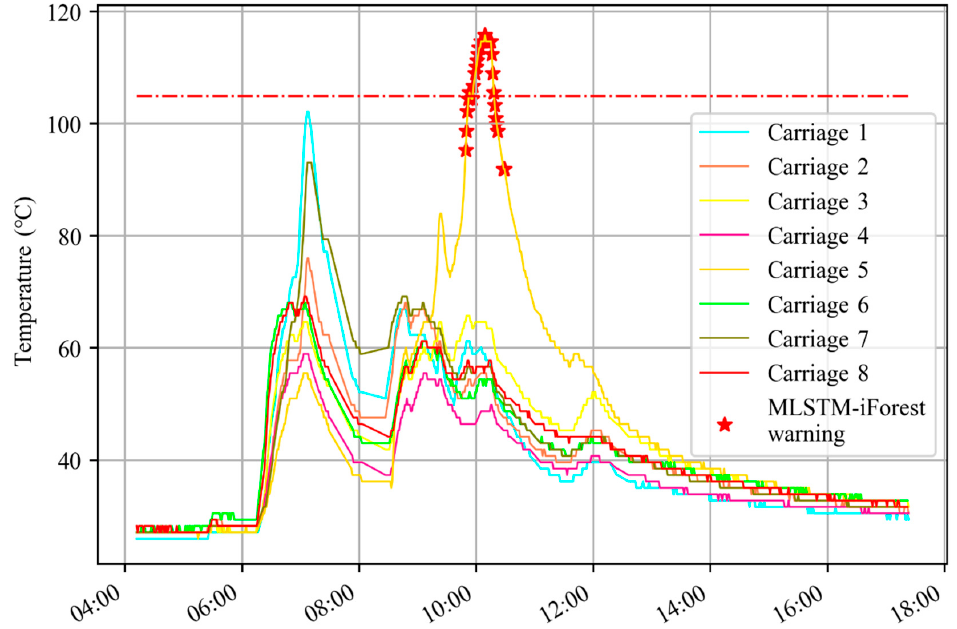
Figure 11. MLSTM-iForest warned a few minutes ahead of EMU-ODS.